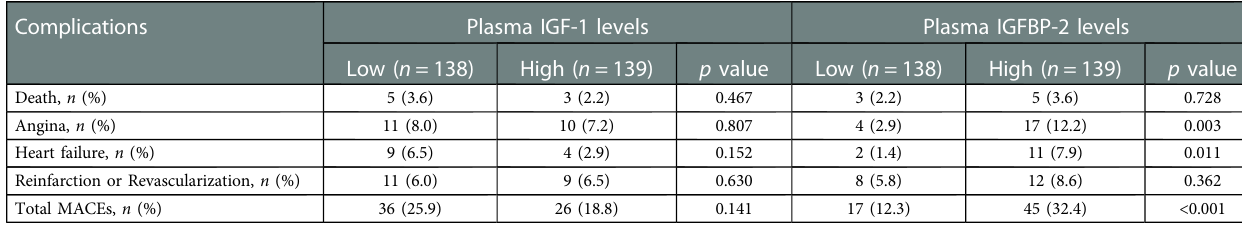
TABLE 4 Major adverse cardiac events according to plasma IGF-1 and IGFBP-2 levels.